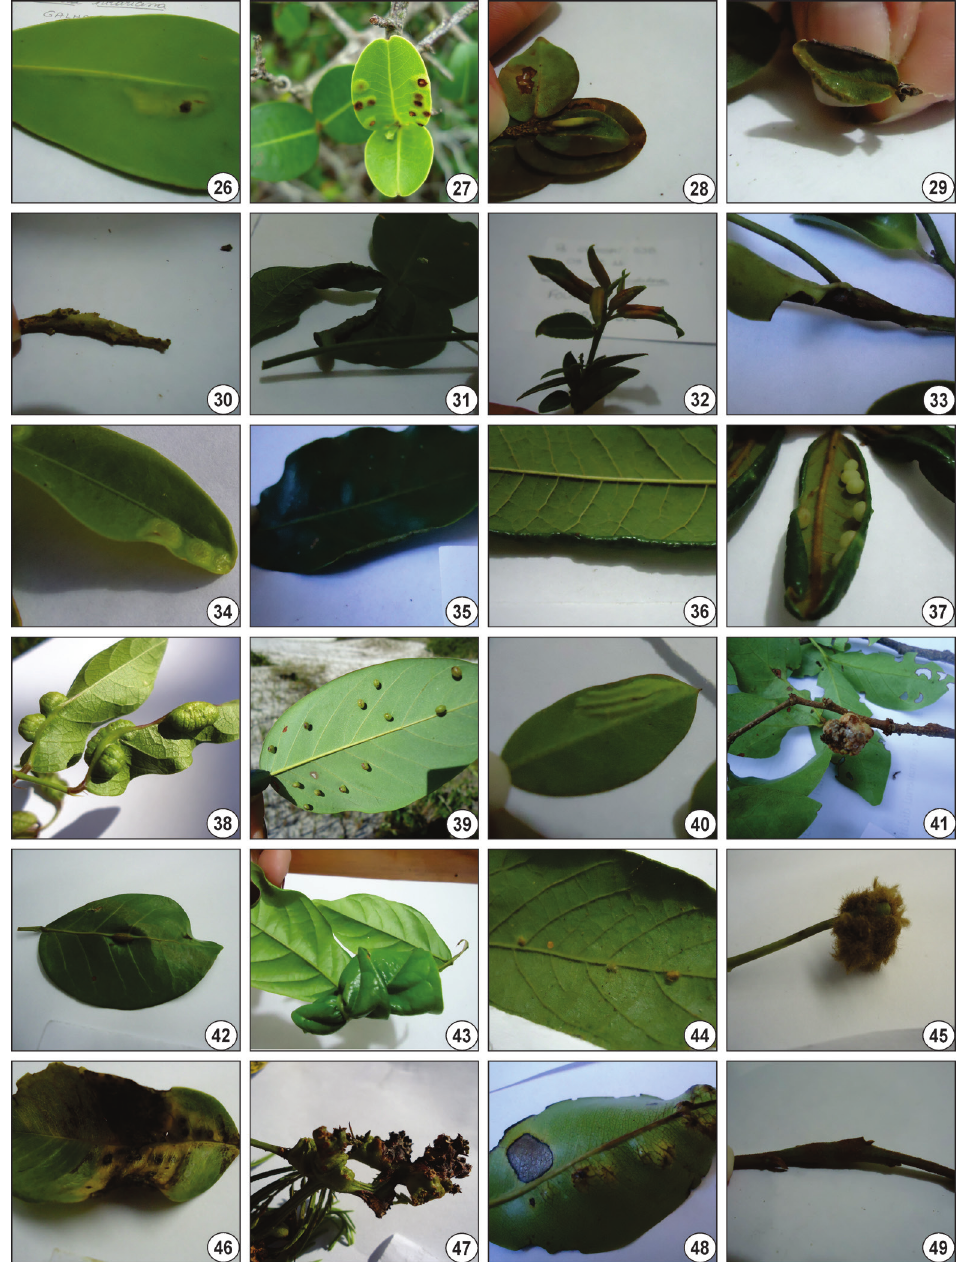
Figures 26-49 - Galling insects from Parque Estadual da Costa do Sol and RPPN Fazenda Caruara (RJ, Brazil). 26, Clusia hilariana , lenticular leaf gall. 27-29, Erythroxylum ovalifolium , 27, lenticular leaf gall, 28, conical bud gall, 29, marginal roll. 30, Croton compressus , stem gall. 31, Dalechampia micromeria , marginal roll. 32, Microstachys corniculata , marginal roll. 33-35, Pera glabrata , 33, stem gall, 34, lenticular leaf gall, 35, marginal roll. 36, Andira legalis , marginal roll. 37, Andira sp., globoid leaf gall. 38, Centrosema virginianum , leaf vein gall. 39, Dalbergia ecastaphyllum , globoid leaf gall. 40, Indigofera sabulicola , lenticular leaf gall. 41-42, Inga laurina , 41, globoid bud gall, 42, leaf vein gall. 43-44, Inga maritima , 43, leaf vein gall, 44, globoid leaf gall. 45-46, Machaerium lanceolatum , 45, globoid bud gall, 46, lenticular leaf gall. 47, Senegalia lacerans , bud gall. 48, Swartzia apetala , lenticular leaf gall. 49, Humiria balsamifera , stem